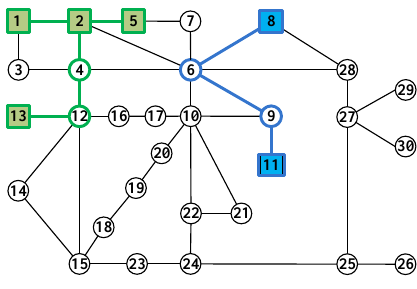
Figure 5. The critical subgraphs.